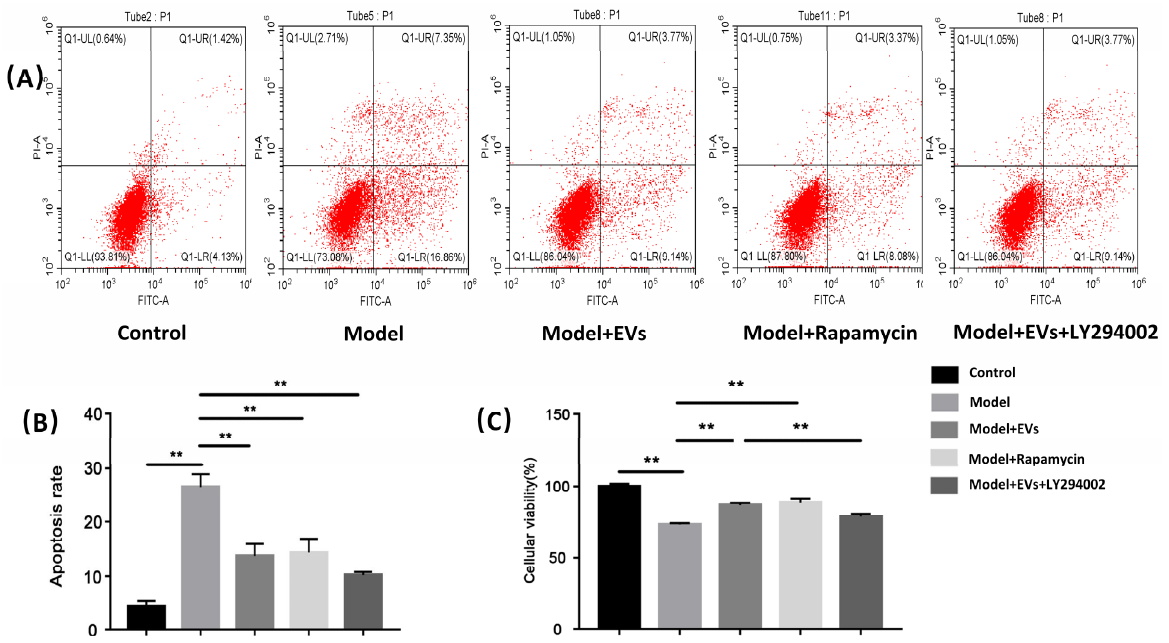
Figure 5. BMSC-EV-derived exosomes BMECs’ viability and protected BMECs against glucocorticoid-induced apoptosis. ( A ) Apoptosis was quantified by flow cytometry after staining with annexin V-FITC/PI. ( B ) Percentage of apoptotic cells in different groups. ( C ) CCK-8 was used to measure viability of BMECs in different groups. Each bar represents the mean ± SD of three independent experiments. ** P < 0.01.